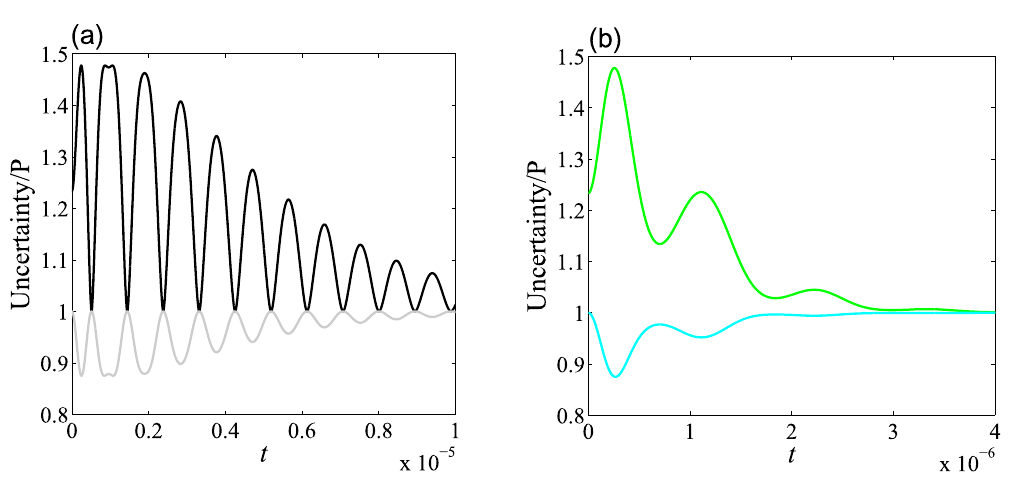
Figure 4. The purity, P , and entropic uncertainty as a function of t , where we have set γ π Ω = = × 10 6 Hz with the initial state constructed with θ π = /4 and φ π = /8 . In Graph ( a ) Θ Ω = . / 0 5 ; the black line represents the uncertainty, while the grey line represents the purity of the atomic evolutive state. In Graph ( b ) Θ Ω = / 5 ; the green line represents the uncertainty, while the cyan line represents the purity of the atomic evolutive